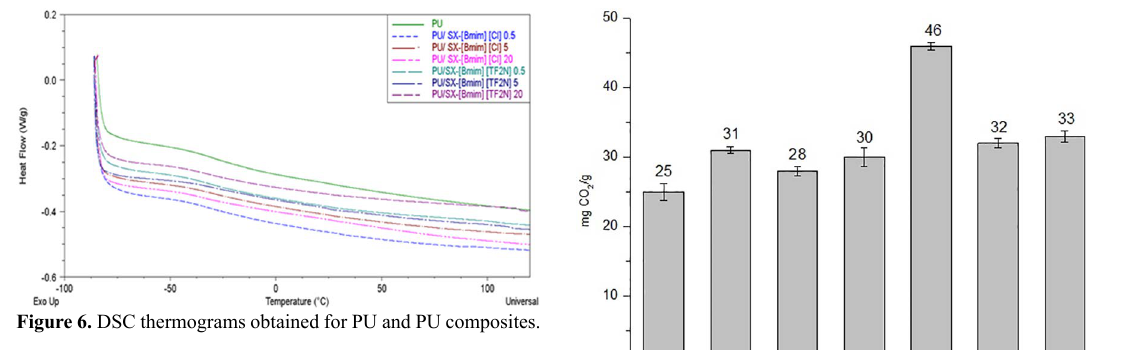
Figure 8. PU and PU composite CO 0.1 bar and 298.15